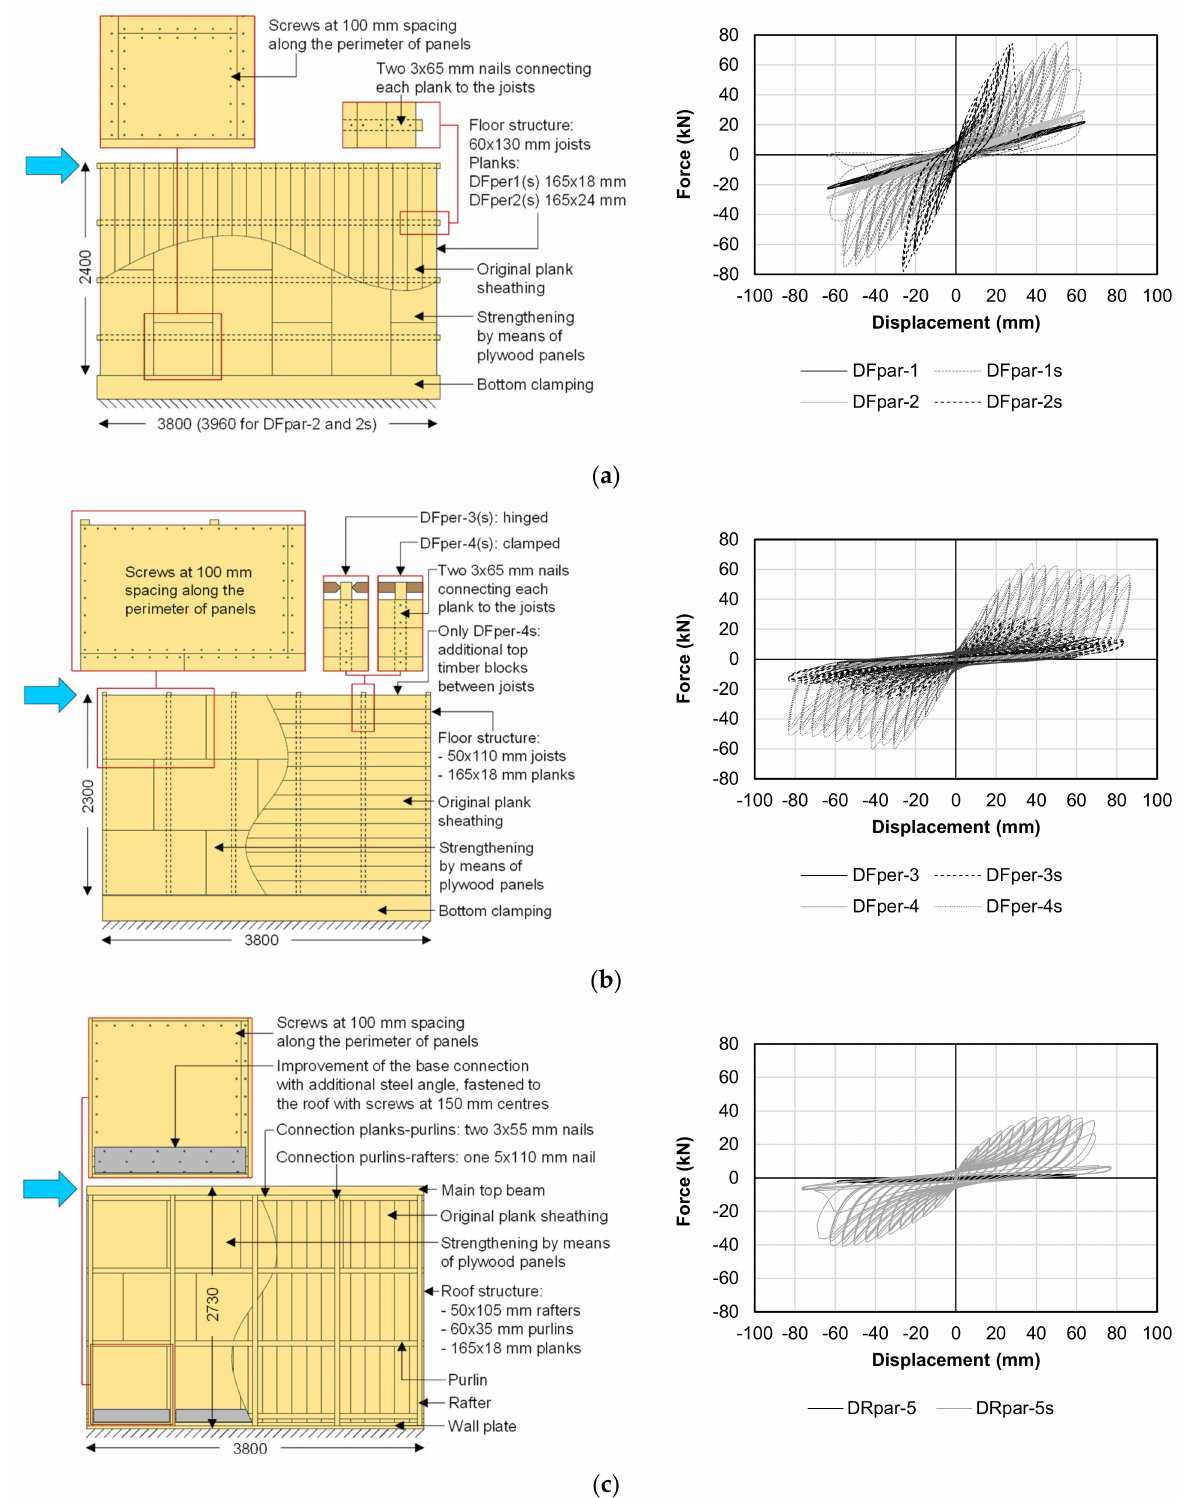
Figure 1. Main characteristics and cyclic in-plane response of the timber diaphragms; floors tested parallel ( a ) and perpendicular to the joists ( b ) and roof pitch ( c ). More details on the retrofitting technique can be found in References